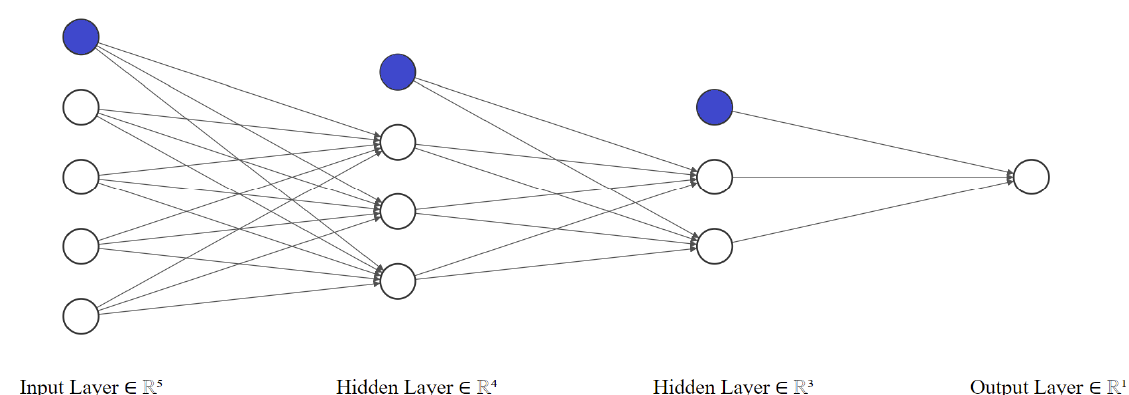
Figure A4. Four-layer trainable neural network model. Table A4. The effect of model complexity on classification results—coordination task (f1 score is the measure by which we evaluate the quality of the model best model colored in green. The least successful model is marked in red).